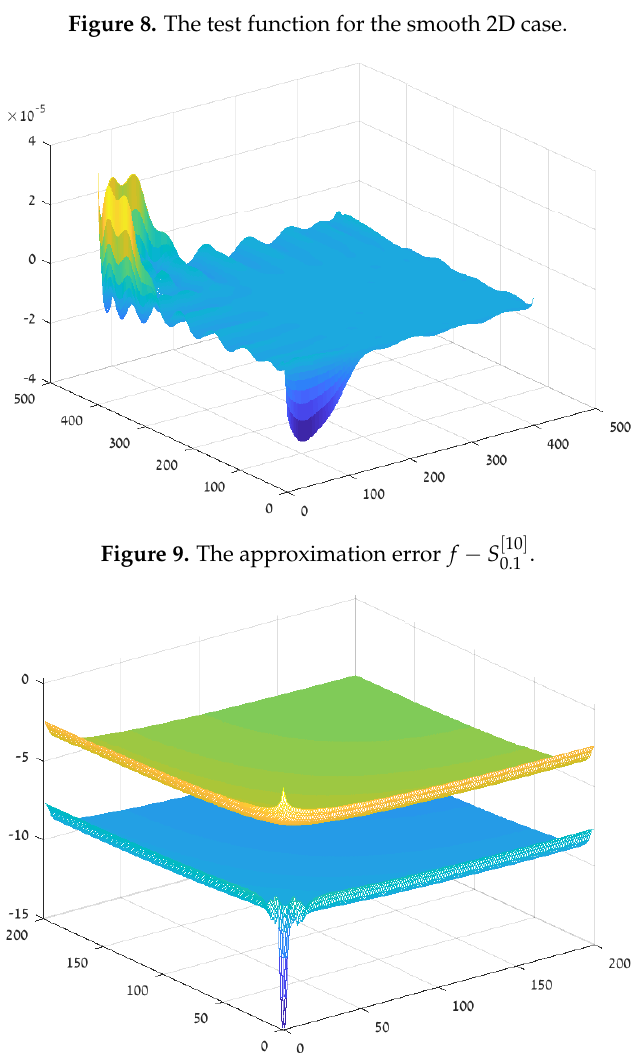
Figure 10. log of the Fourier coefficients before (green), and after 10